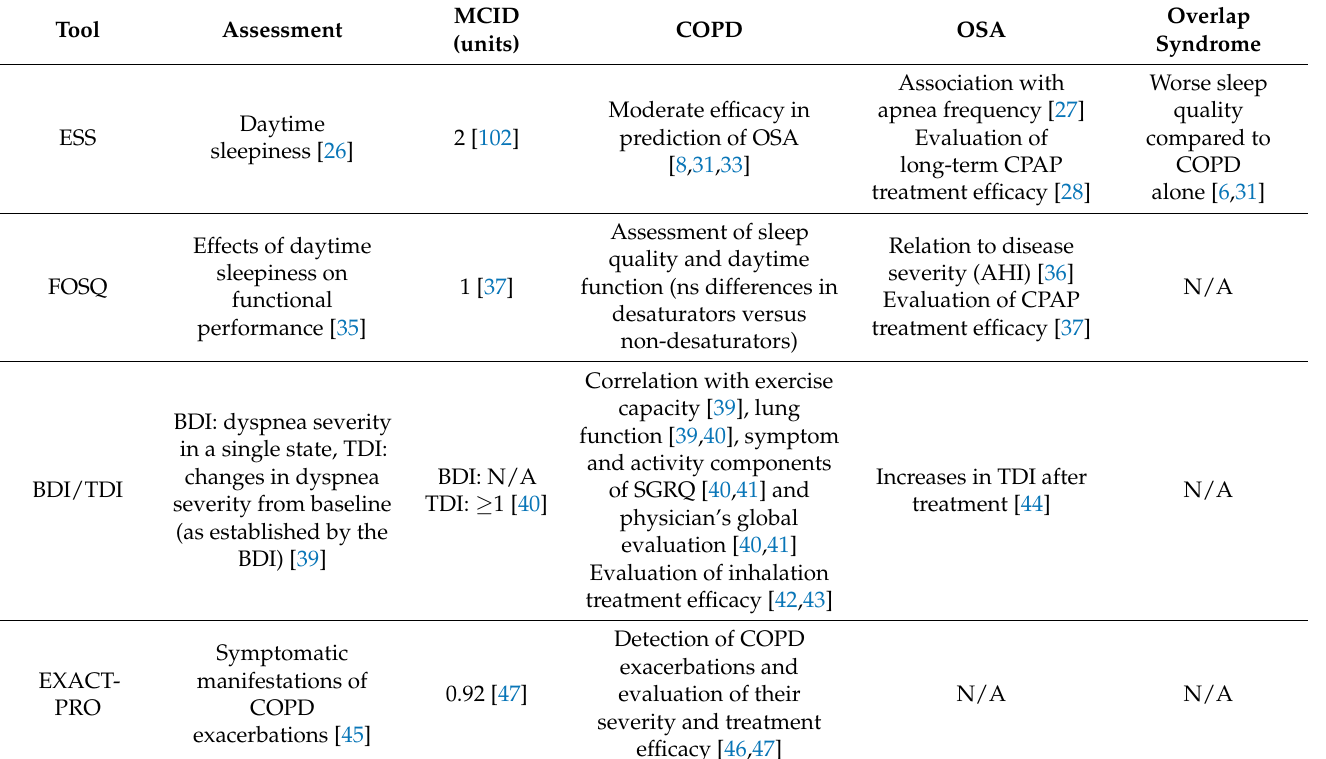
Table 1. PROMs related to